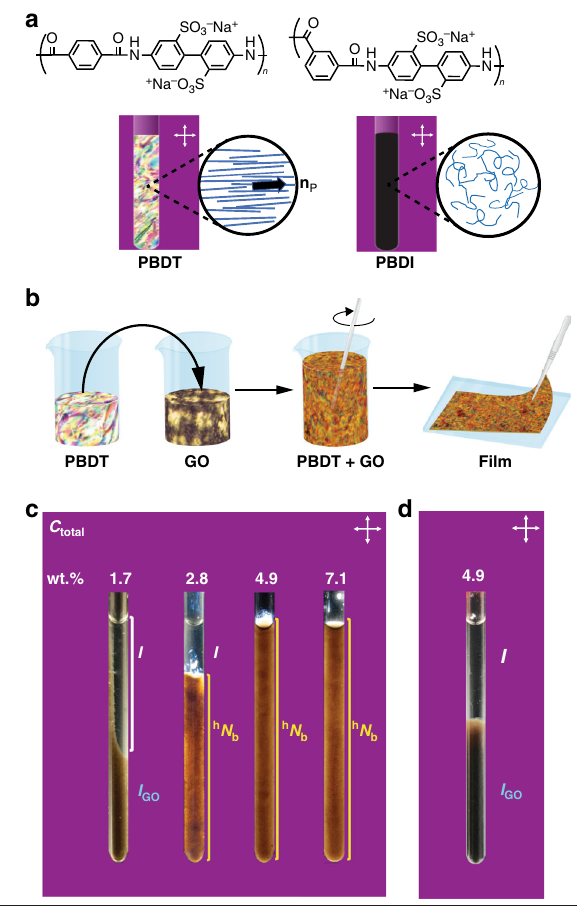
Fig. 1 Molecular structures of polymers, nanocomposite synthesis and, hybrid biaxial nematics. a Molecular structures of PBDT and PBDI, mesophases (images from crossed polarized optical microscopy have been cropped into NMR tube shapes using Adobe Illustrator TM ), and chain secondary structures (schematic insets). PBDT has a rectilinear